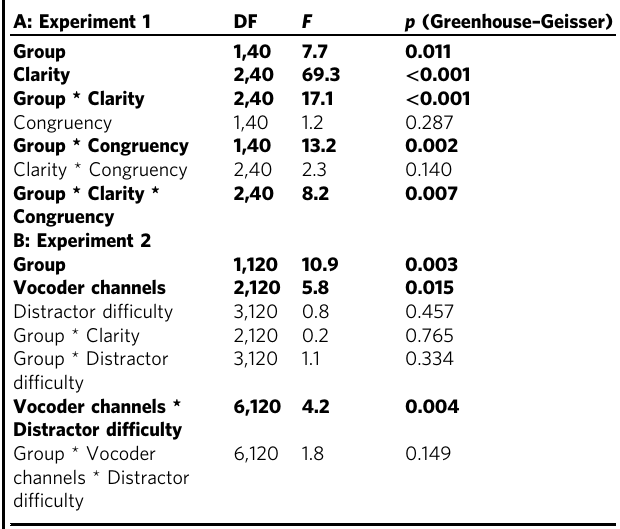
Table 2 Repeated measures ANOVA of behavioural data from experiments 1 (Fig. 1b) and 2 (Fig. 1d)